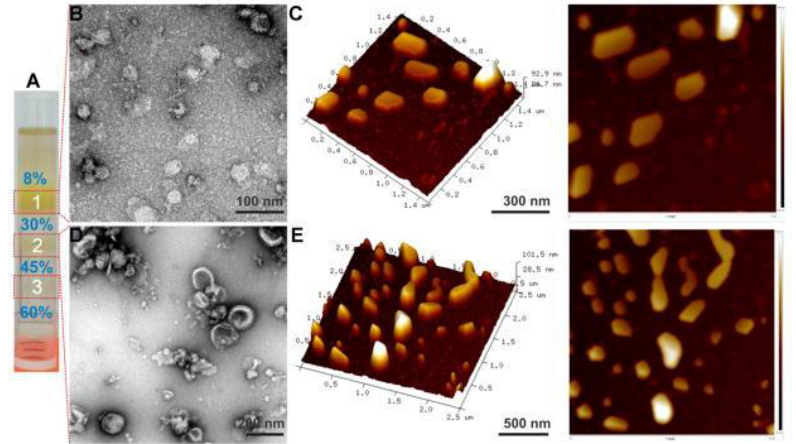
Figure 1. Ginger derived EVs. Sucrose gradient ultracentrifugation depicts three bands ( A ). Visualization and characterization of ginger derived EVs using Transmission Electron Microscope (TEM) ( B , D ) and atomic force microscope (AFM) ( C , E ) are shown. Reproduced with permission from ref. [33].